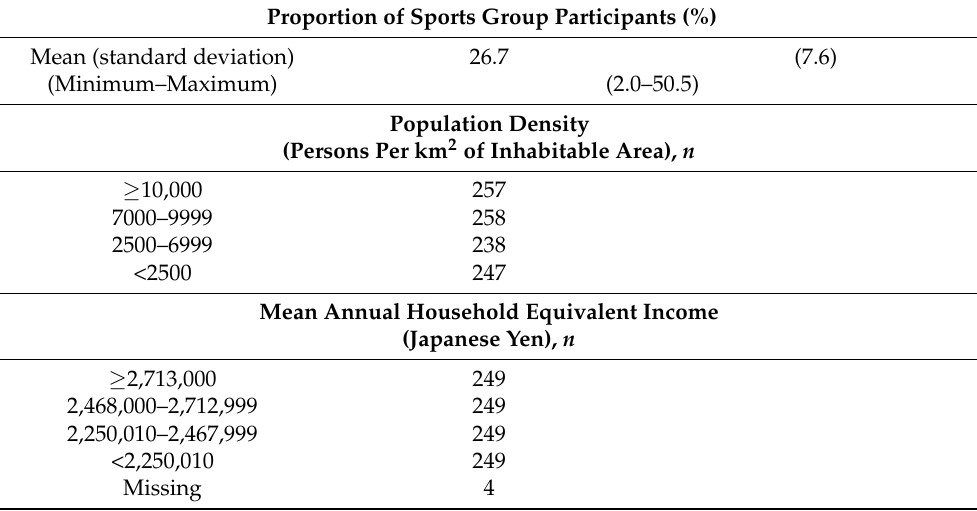
Table 2. Characteristics of community-level variables ( n = 1000).